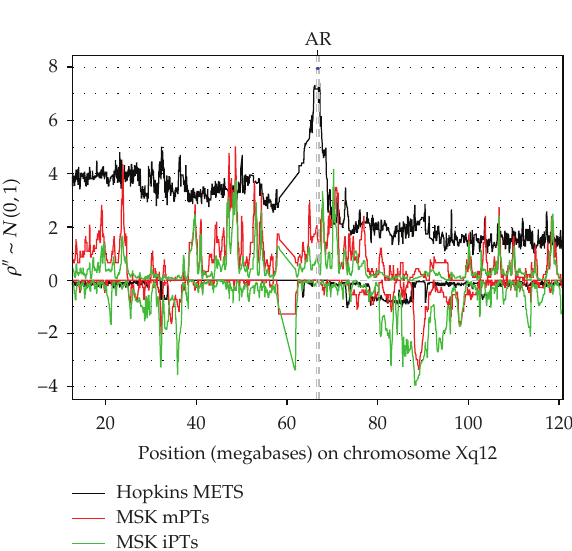
Figure 5: Copy number profile, ρ (cid:2)(cid:2) shows an amplification of a region on chromosome X harboring the androgen receptor (cid:2) AR (cid:3) locus. The x -axis represents the ordered chromosome position and the y -axis represents standardized population frequencies exhibiting amplifications (cid:2) above 0 (cid:3) and deletions (cid:2) below 0 (cid:3) . The three populations of tumors are represented as red, black, or green lines for mPTs, androgen ablation treated metastases (cid:2) METS (cid:3) , and iPTs,